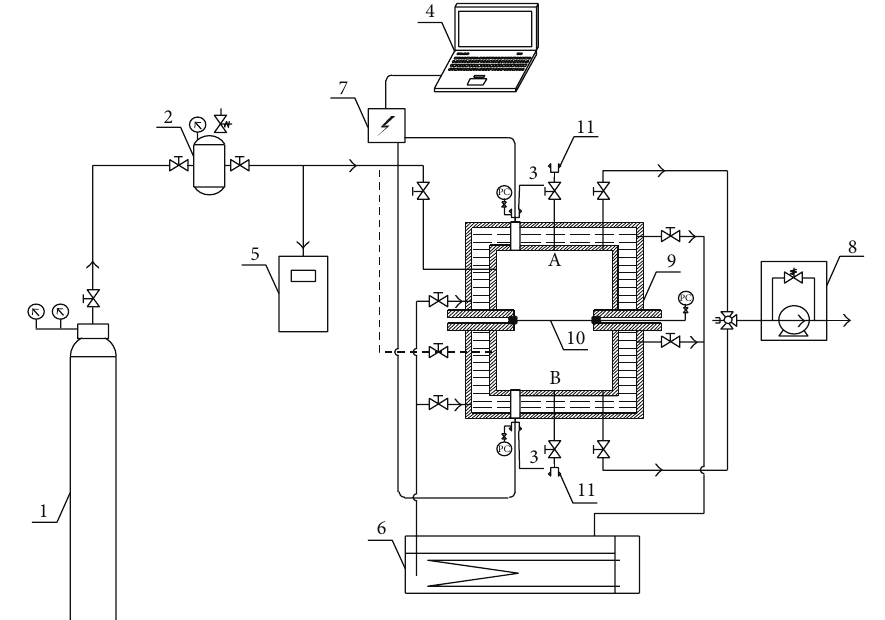
Figure 1: Diagram of the laboratory unit for the determination of CO 2 /CH 4 permeation: 1: CO 2 /CH 4 gas container, 2: gas sample container, 3: pressure sensor, 4: computer, 5: CO 2 analyser, 6: thermostat, 7: A/D converter, 8: vacuum pump, 9: chamber, 10: SILM, and 11: